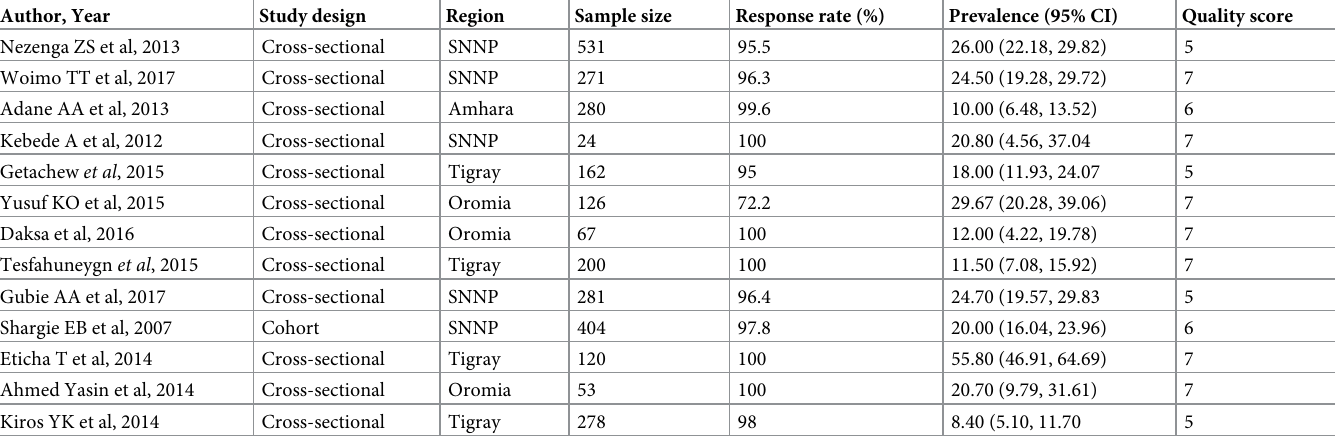
Table 1. Summary of included studies evaluating the prevalence and risk factors of non-adherence to anti TB medication in